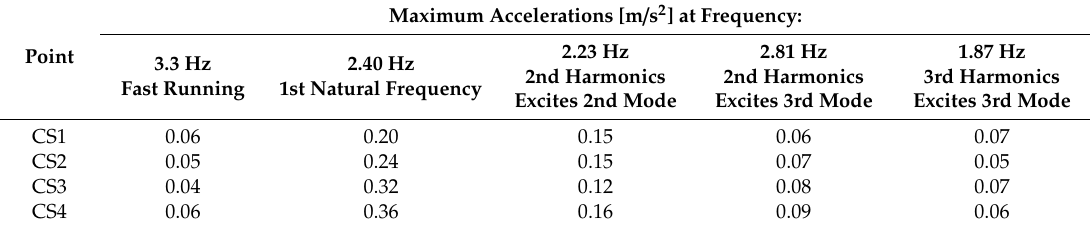
Table 9. Maximum vertical accelerations generated by a single pedestrian running obtained at the representative points of the cable-stayed footbridge with the RC slab for the selected frequencies.